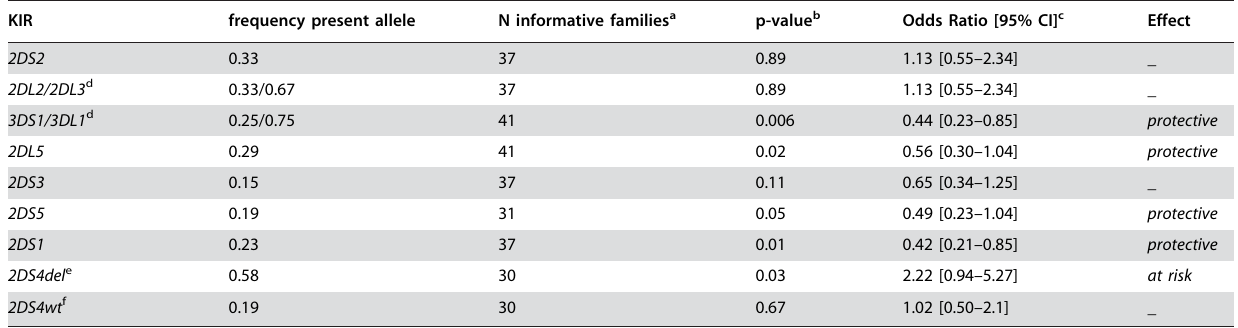
Table 2. Results of the family-based association study between KIR genes and Hodgkin’s lymphoma using a dominant model .. ... .... ... ... .... ... ... .... ... ... .... ... ... .... ... ... .... ... ... .... ... ... .... ... ... .... ... ... .... ... ... .... ... ... .... ... ... .... ... ... .... ... ... .